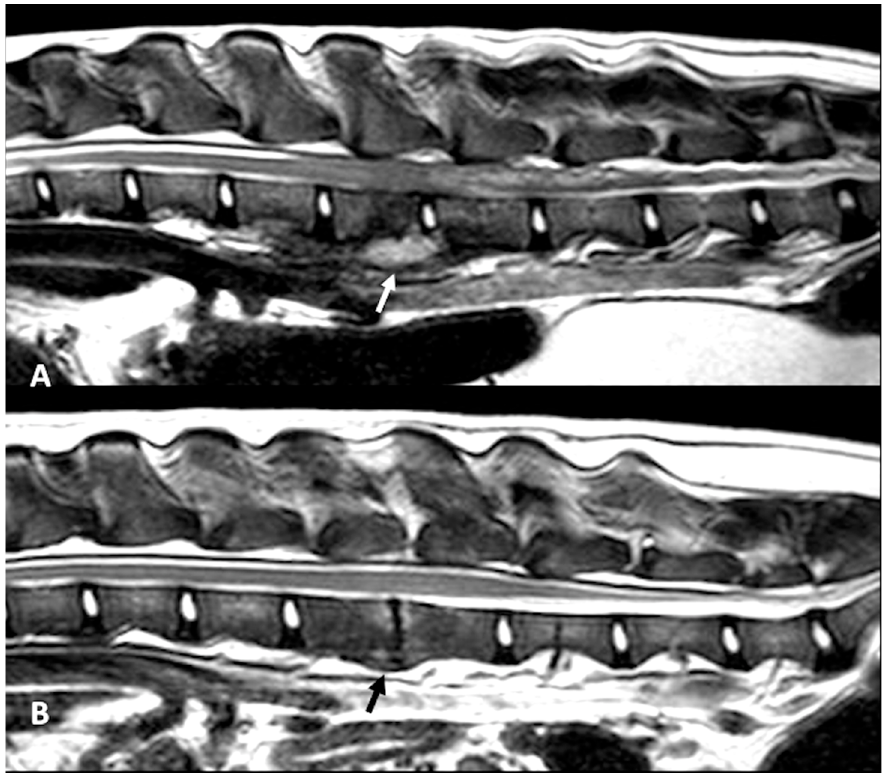
Figure 2. MRI T2-W sagittal plane at time of presentation ( A ) and follow-up at 4 months ( B ) in a dog with SEE surgically treated. On the intervertebral disk L3–L4 there is an infiltrative lesion also affecting the ventral paravertebral muscles and vertebral body of L3 (white arrow). The follow-up image ( B ) demonstrates the resolution of the paravertebral lesion and residual changes with new bone formation, loss of intervertebral space and mild vertebral marrow edema (black arrow).